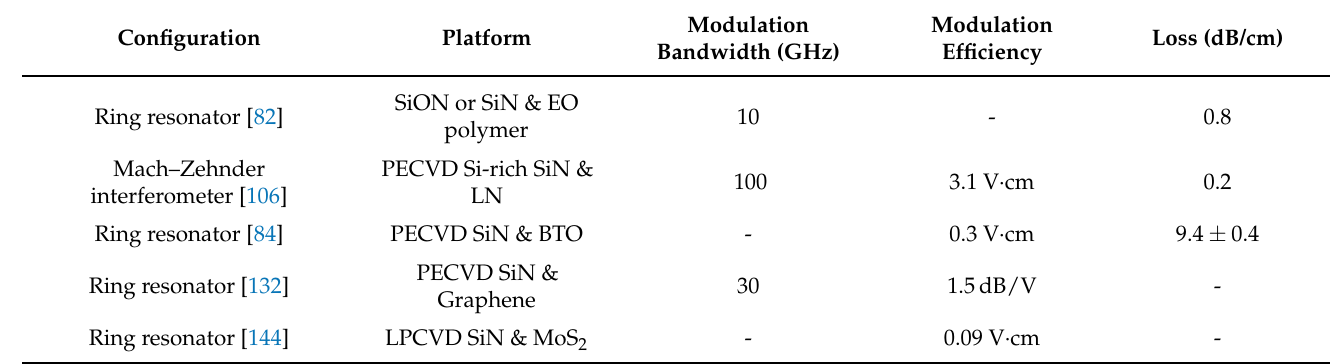
Table 6. State-of-the-art performance matrix for the fabricated high-speed modulators in the SiN platform. The table includes reported results for C- communication